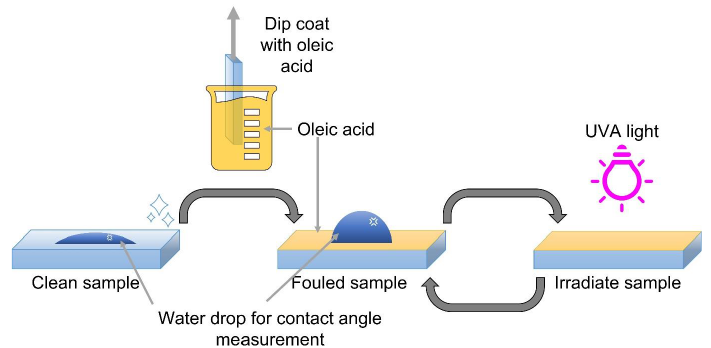
Figure 2. Experimental scheme of ISO 27448:2009 where the water contact angle of a clean sample is measured, the sample is fouled with oleic acid via dip coating, measured again for its water contact angle and irradiated with UV-A light alternatively until the final angle is reached. Table 1. Overview of the water contact angles of the clean, pre- treated, unfouled surface (θ clean ), the oleic-acid- fouled surface before UV irradiation (θ 0 ), the final contact angle after UV irradiation (θ f ) and irradiation time needed. A dash (-) is used for values that could not be measured.